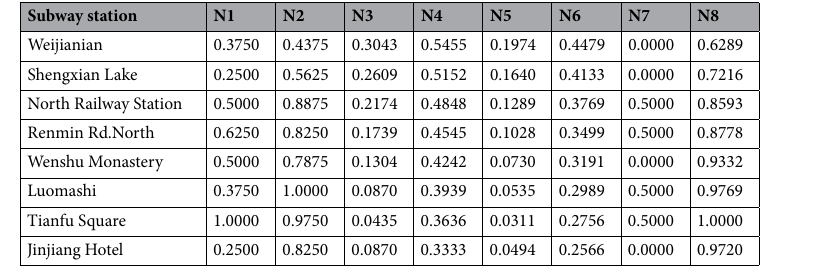
Table 4. The values of node indicators in each subway station normalized by Min–Max Normalization method.